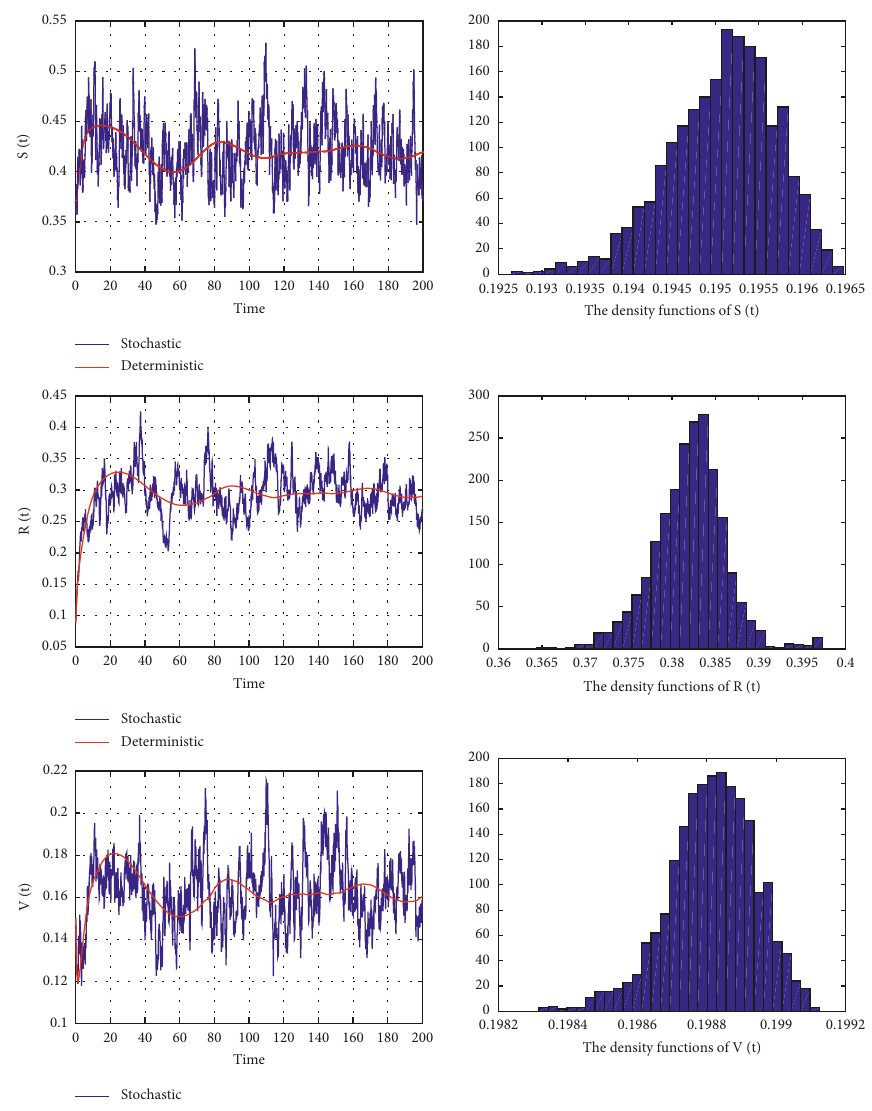
Figure 3: The solutions of the stochastic system (4) and the undisturbed system (2) left banners such that 􏽢 R the density function diagram of S ( t ) , R ( t ) , and V ( t )